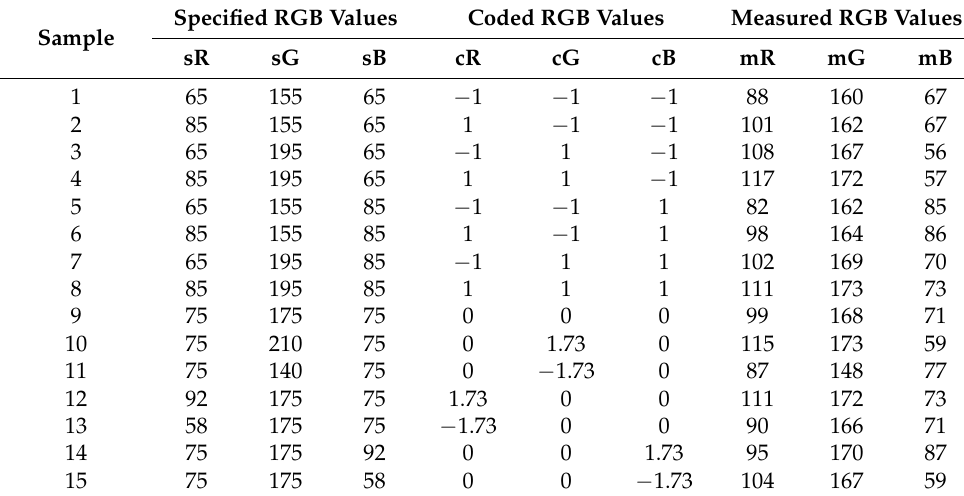
Table A3. CCD matrix and results for Case 3.